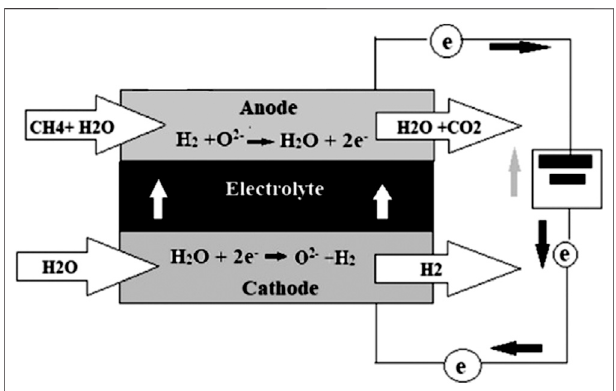
FIGURE 2 | A schematic of a CH 4 assisted-SOFEC.